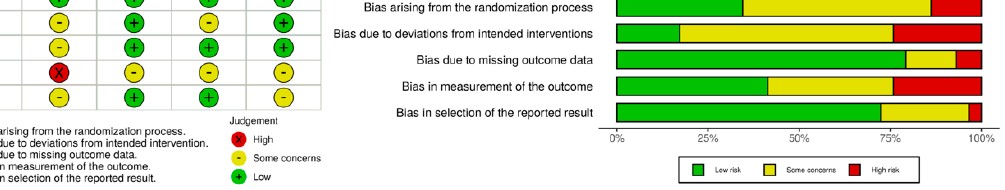
Figure 2. Risk of bias 2.0.